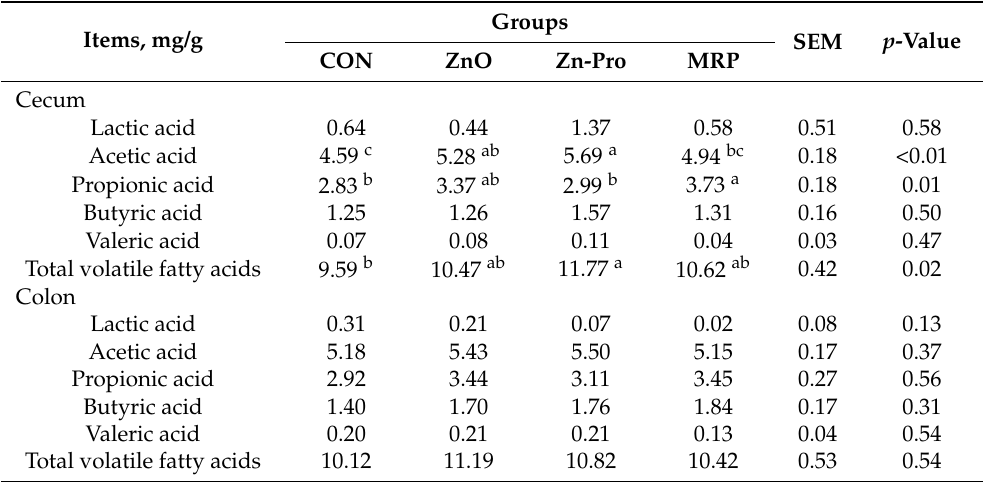
Table 6. Effects of different treatments on volatile fatty acid concentrations in the different groups on d 28 of